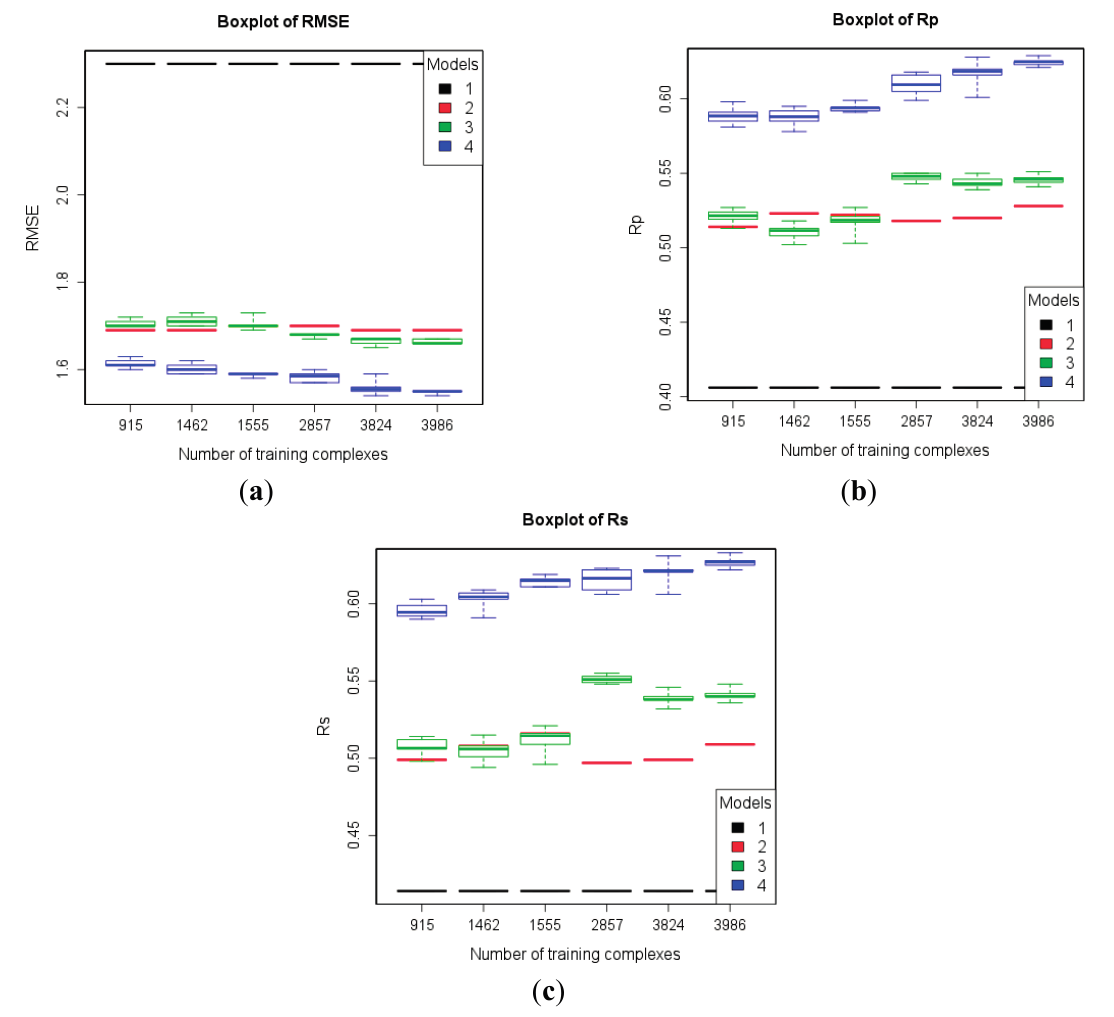
Figure 6. Performance of the four models trained with six subsets of PDBbind v2012 general set after subtracting refined12 on the test set of v2013 refined set minus v2012 refined set ( n = 382) according to RMSE ( a ); R p ( b ); and R s ( c ). Models: 1 (Vina), 2 (MLR::Vina), 3 (RF::Vina) and 4